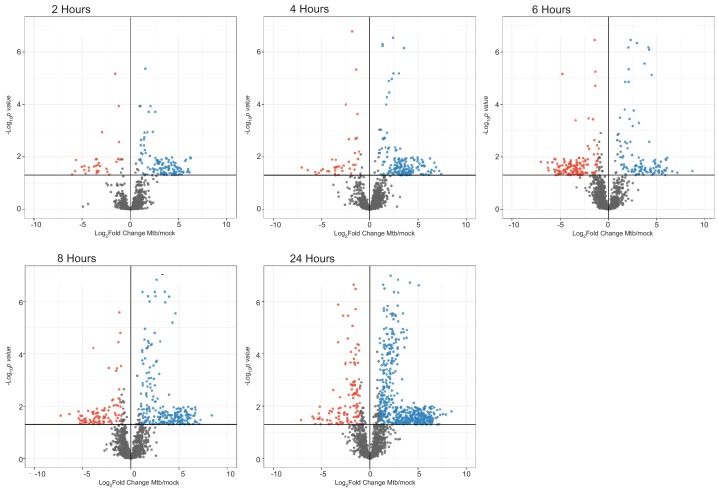
Changes in host protein ubiquitylation during a time course of Mtb infection.Volcano plots displaying the changes in di-Gly modified peptides during Mtb infection. Ubiquitylated peptides with a p value less than 0.05 and log2(fold change) greater than one are colored red. Ubiquitylated peptides with a p value less than 0.05 and log2(fold change) less than −1 are colored blue.